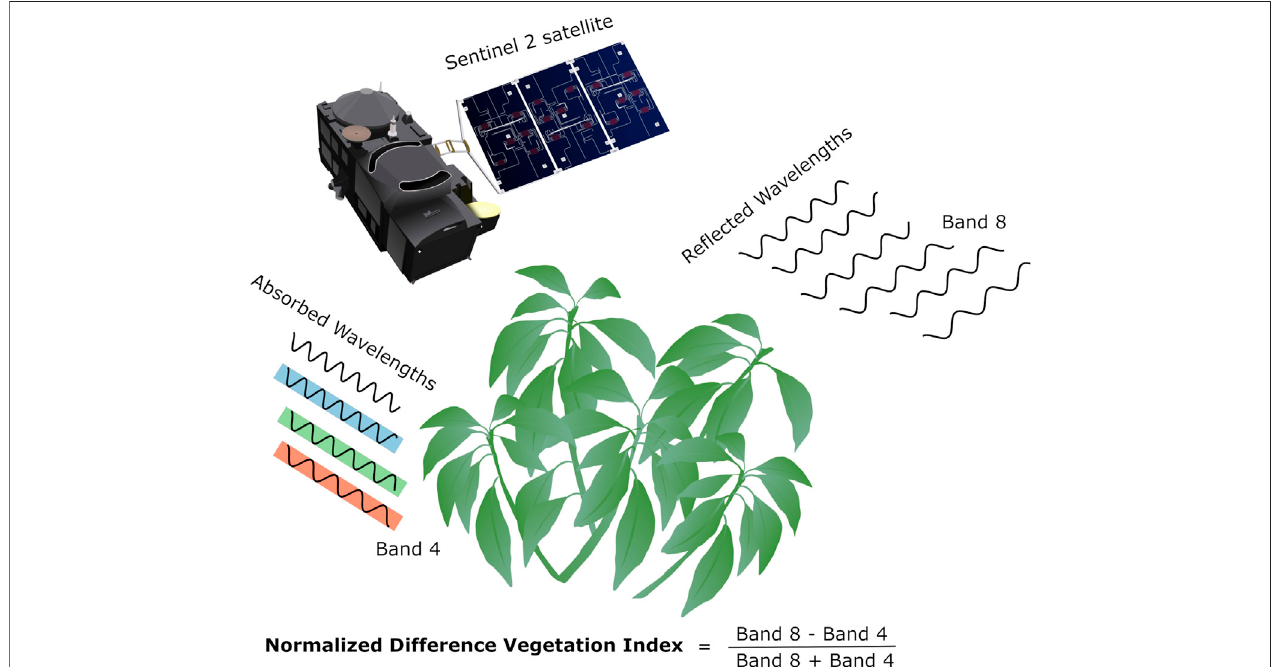
FIGURE 4 | Raster indices capitalize on the fact that different objects absorb and re fl ect different regions of the electromagnetic spectrum. For example, green plants absorb energy in the 400 – 700 μ m wavelengths to photosynthesize, while re fl ecting wavelengths of 700 – 1,100 μ m. To serve as an indicator for vegetation, the Normalized Difference Vegetation Index calculates the ratio of the difference between and sums of Sentinel ’ s Bands 4 and 8.